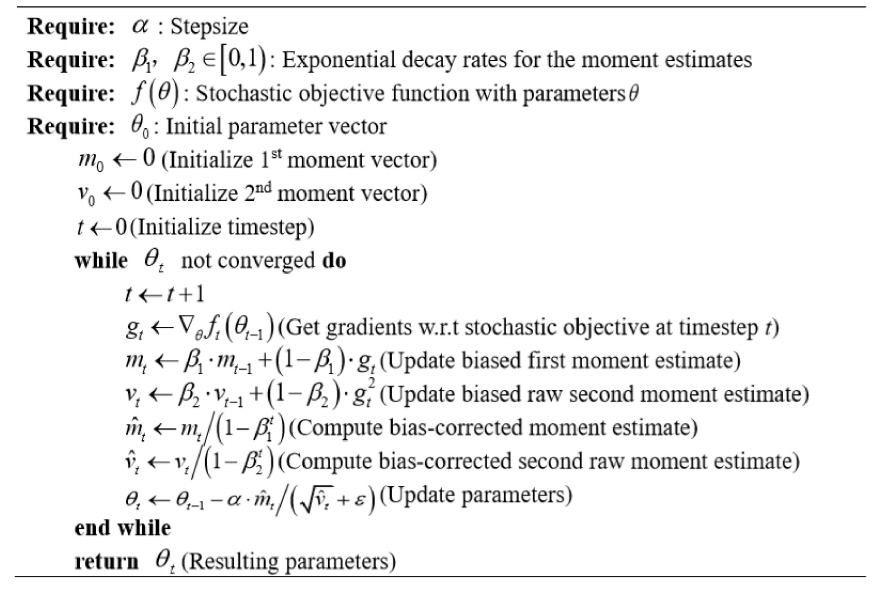
Figure 3. The pseudo-code of the Adam optimization